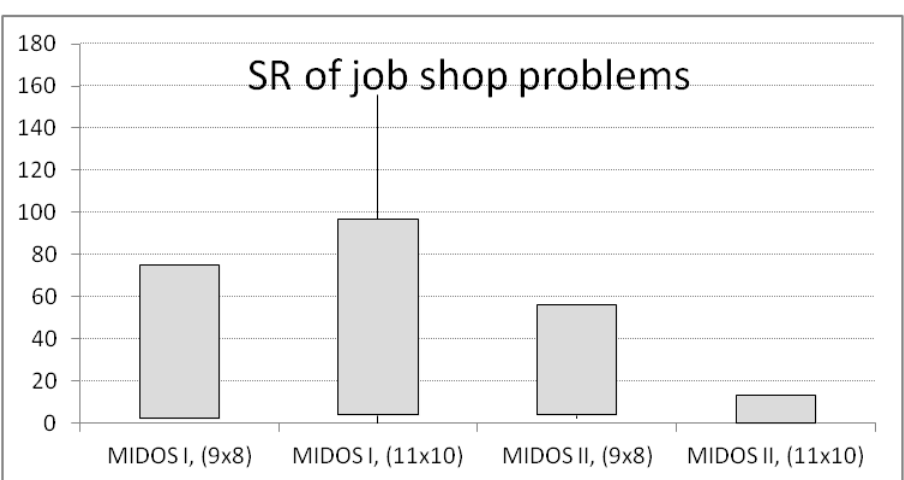
Figure 7. The SR of the predictive schedules achieved by the ACO and MIDOS rules for scheduling problems: (9 × 8) and (11 × 10).